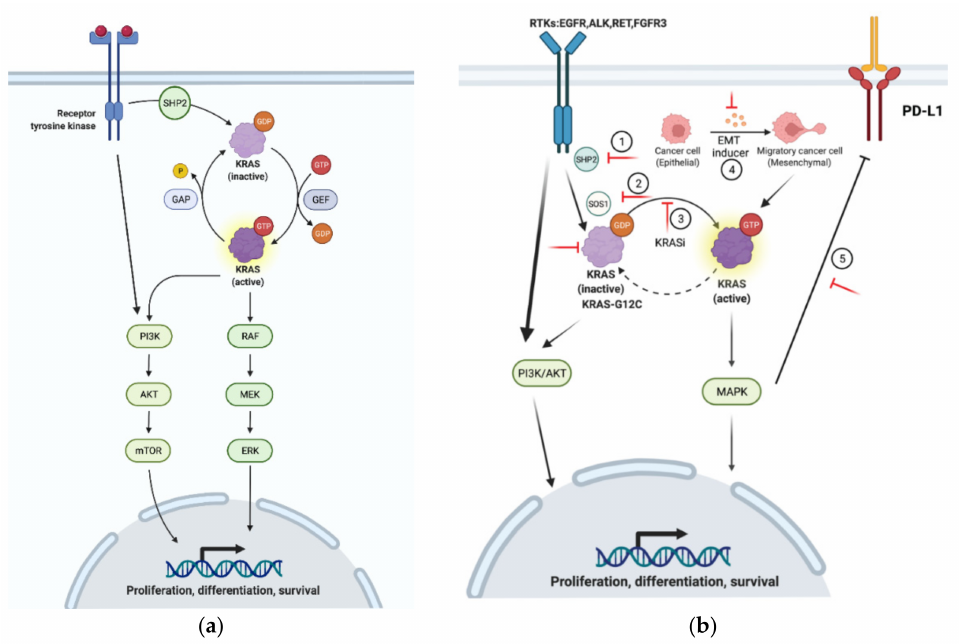
Figure 2. Mechanisms of resistance to KRAS G12C inhibition. ( a ) Under physiological setting, KRAS cycles between active and inactive status. ( b ) Mechanisms of resistance to KRAS G12C inhibitors: (1–3) SHP2, SOS1, and KRAS-GTP activate KRAS and its downstream cascades, which provides positive feedback to RTKs and the PI3K/AKT/mTOR pathway; (4) EMT increases the level of KRAS-GTP and renders KRAS-mutant cells less sensitive to KRAS inhibitors; (5) MAPK promotes PD-L1 expression and leads to the immune evasion of KRAS-mutant cancer cells. The red lines indicate the targets for therapeutic intervention to overcome KRAS G12C inhibitor